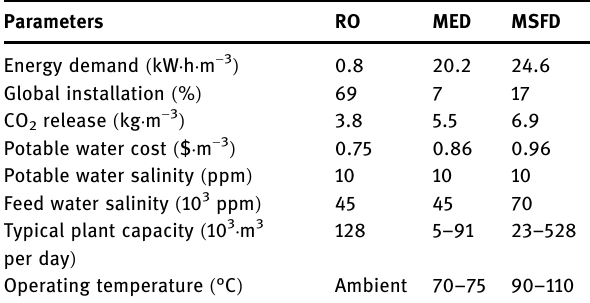
Table 1: Comparison of RO, MED and MSFD [ 29,37 – 42 ] Parameters